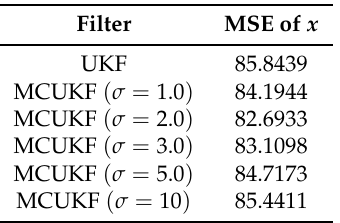
Table 2. MSEs of x in non-Gaussian measurement noise.